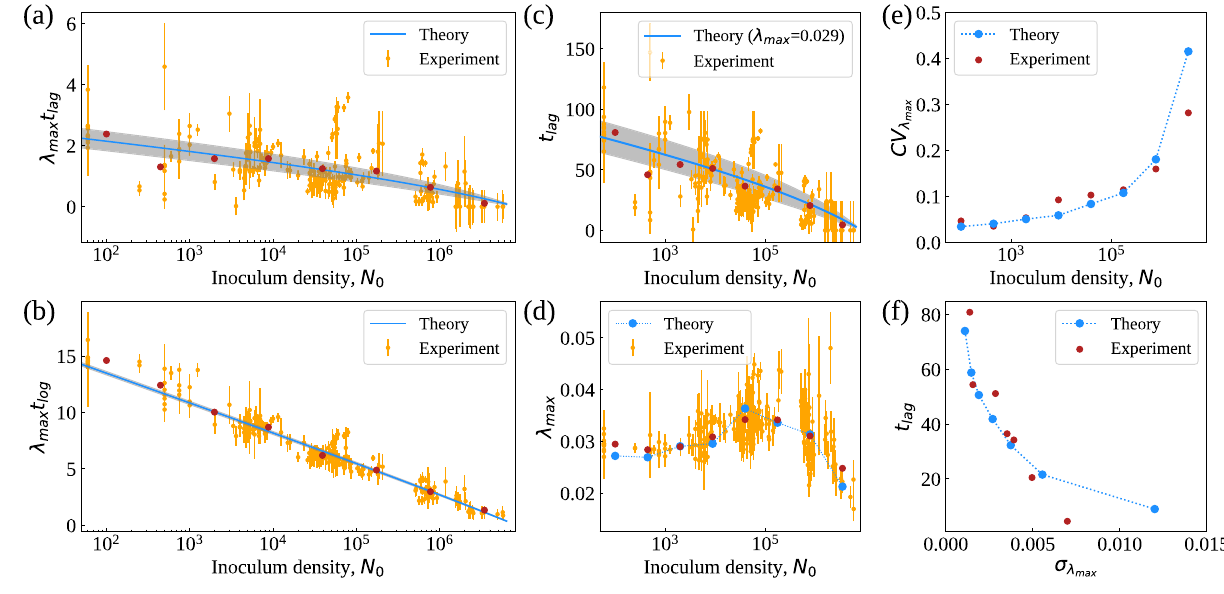
Figure 5. ( a , b ) Behaviour of (cid:31) max t lag ( a ) and (cid:31) max t log ( b ) versus N 0 from experiments (orange markers), empirical means (red markers) and theoretical predictions based on Eqs. (1) and (2). Gray shaded areas represent the 95% confidence intervals. ( c – e ) Empirical behaviour of t lag ( c ), λ max ( d ) and of its relative standard deviation CV tlag ( e ) versus N 0 in individual experiments (orange markers), together with the empirical means (red markers) and the theoretical predictions based on Eq. (1) with the single adjustable parameter p (blue line in ( c ) and blue markers in ( d ) and ( e )). See Materials and Methods for details. ( f ) Empirical relationship between the mean lag time t lag and the standard deviation of the maximal growth rate, σ λmax (red markers). Blue markers represent the theoretical prediction based on Eq. (1) (see Materials and Methods for